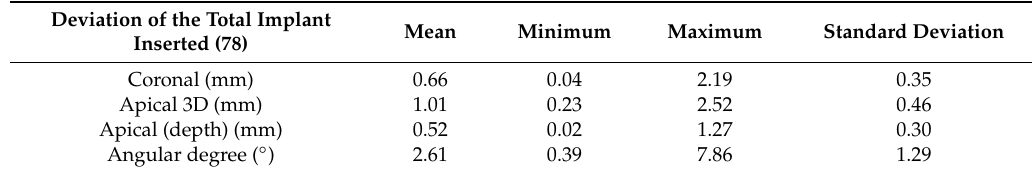
Table 1. Mean, maximum, and minimum of the coronal, apical 3D, apical vertical (depth), and angular deviations of the total implants inserted using a dynamic navigation system ( n =